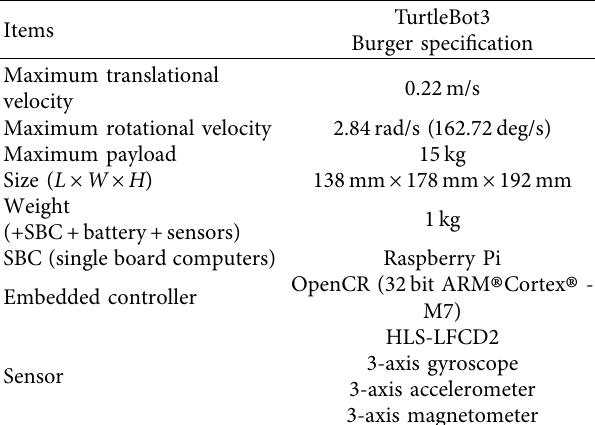
Table 1: Specifcation of the TurtleBot3 Burger.